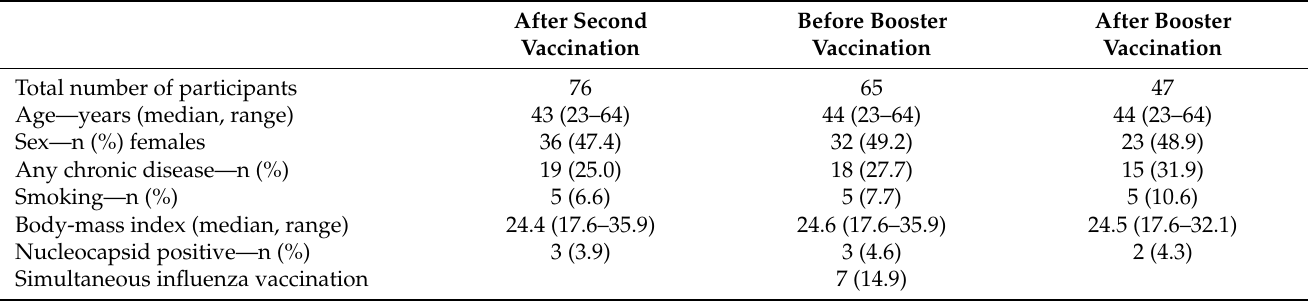
Table 1. Baseline characteristics of study